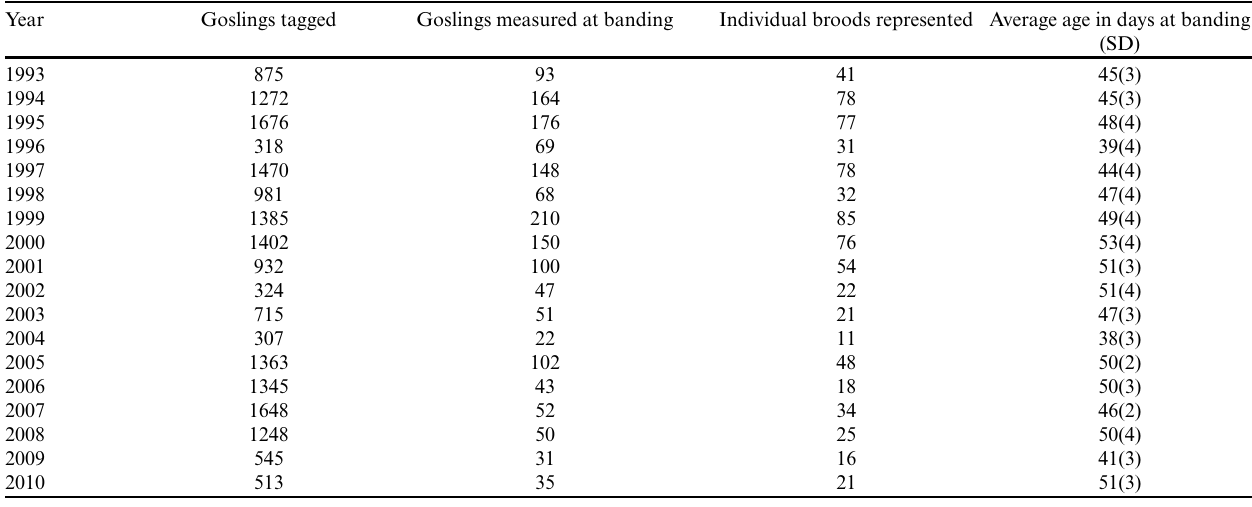
Table 1 . Number of Canada Goose goslings that were web tagged at hatch, the number captured at banding in the same year, and the number of individual broods represented by recaptured goslings and average age at capture on Akimiski Island, Nunavut, 1993-2010.